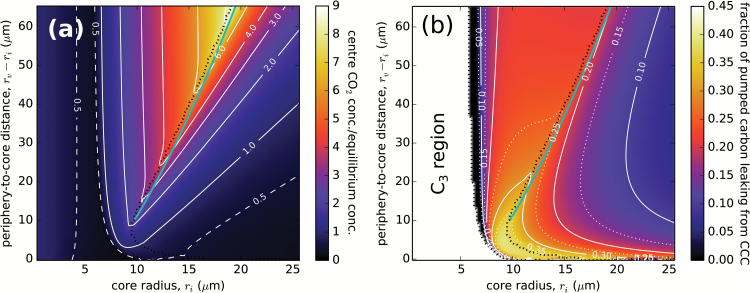
CO2 concentration and leakage. (a) Concentration of CO2 in the cell centre relative to the external dissolved concentration (i.e. the concentration of dissolved CO2 in equilibrium with air at standard atmospheric pressure and 20 °C, cC (r=0)/cCeq, as a function of ri and rv–ri. (b) CO2 leakage from the cell core as a proportion of the C4 pump current. The optimal-geometry line is marked light-blue. Other lines are as in Fig. 3. Parameters are as in Fig. 2.